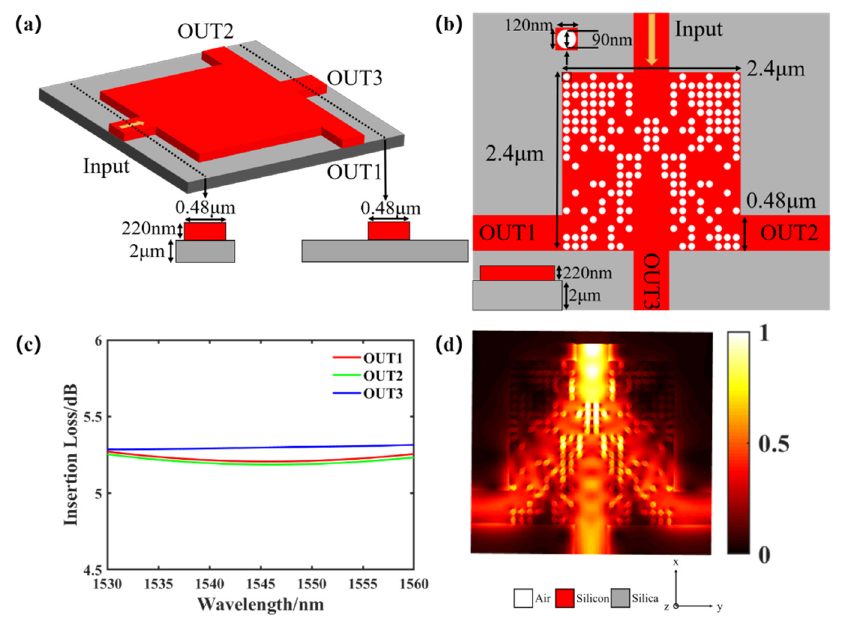
Figure 4. The simulated results of LRDPS. ( a ) Initial structure before optimization. ( b ) The final structure after optimization. ( c ) are the IL of each port of LRDPS. ( d ) Simulated optical field distri ‐ butions.